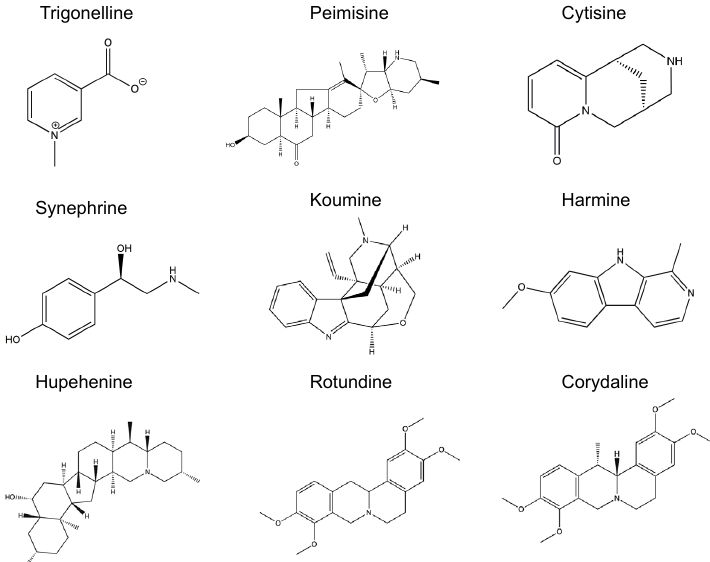
Figure 1. Chemical structures of nine natural alkaloid compounds to test their effect on α -syn seeded fibril formation and toxicity.